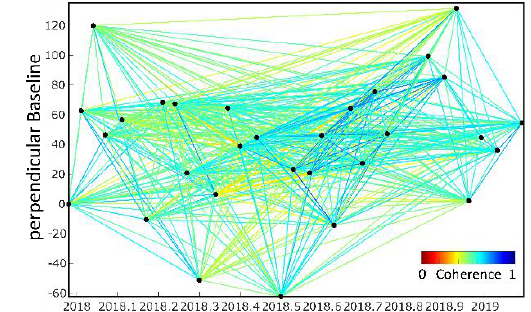
Figure 1. SBAS network representing interferometric pair colored based on the average coherence value of each interferogram. Horizontal and